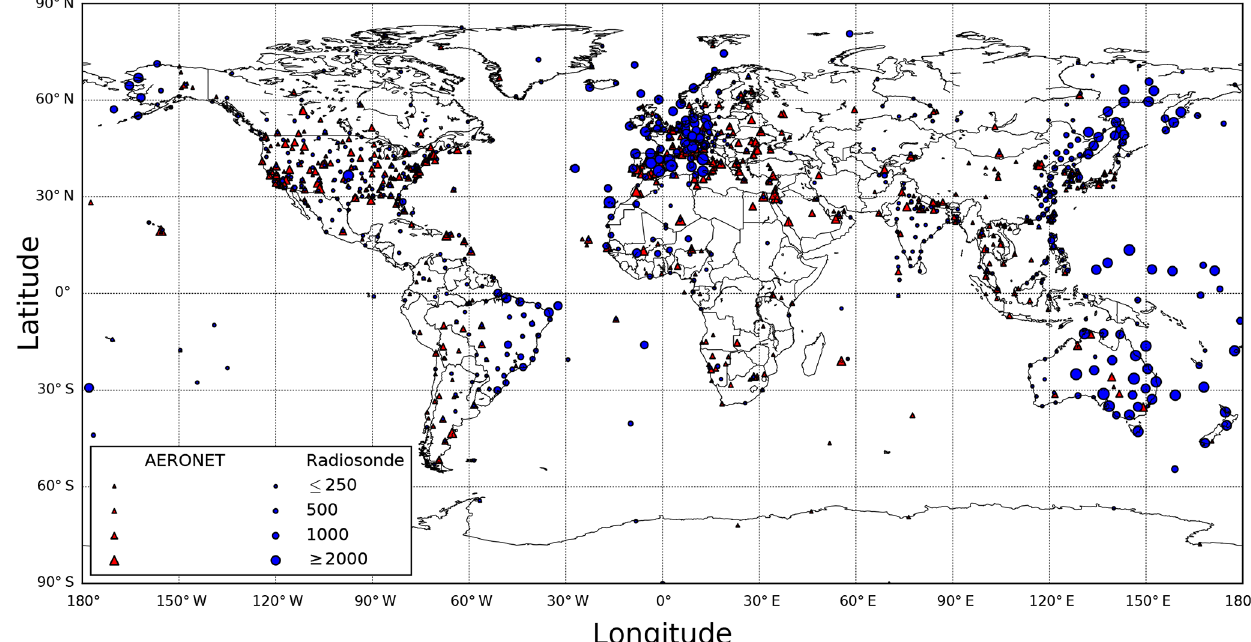
Figure 2. Locations of sun photometer (red triangles) and radiosonde (blue circles) stations providing co-located TCWV measurements with GOME-2 satellite observations. The size of the markers is proportional to the number of valid observations